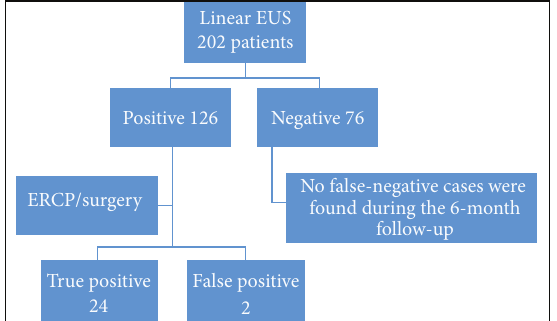
Figure 2: Patient flow chart. One hundred twenty-six patients were positive for common bile duct stones according to linear endoscopic ultrasound (EUS) findings. Of 76 patients, there were no false-negative cases identified during the 6-month follow-up. ERCP, endoscopic retrograde